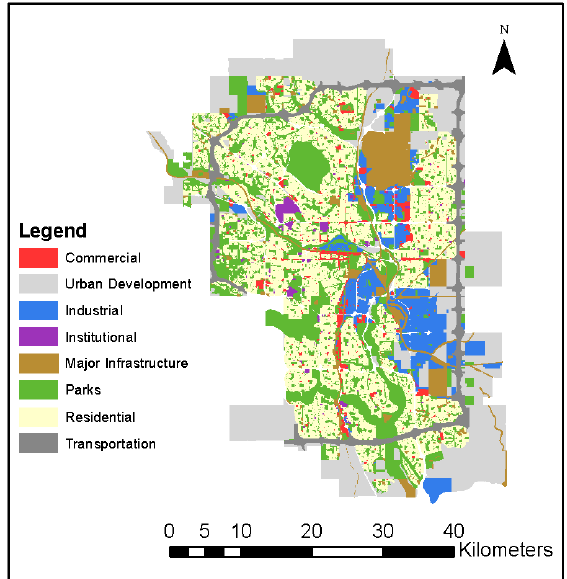
Figure 7. Land use of city of